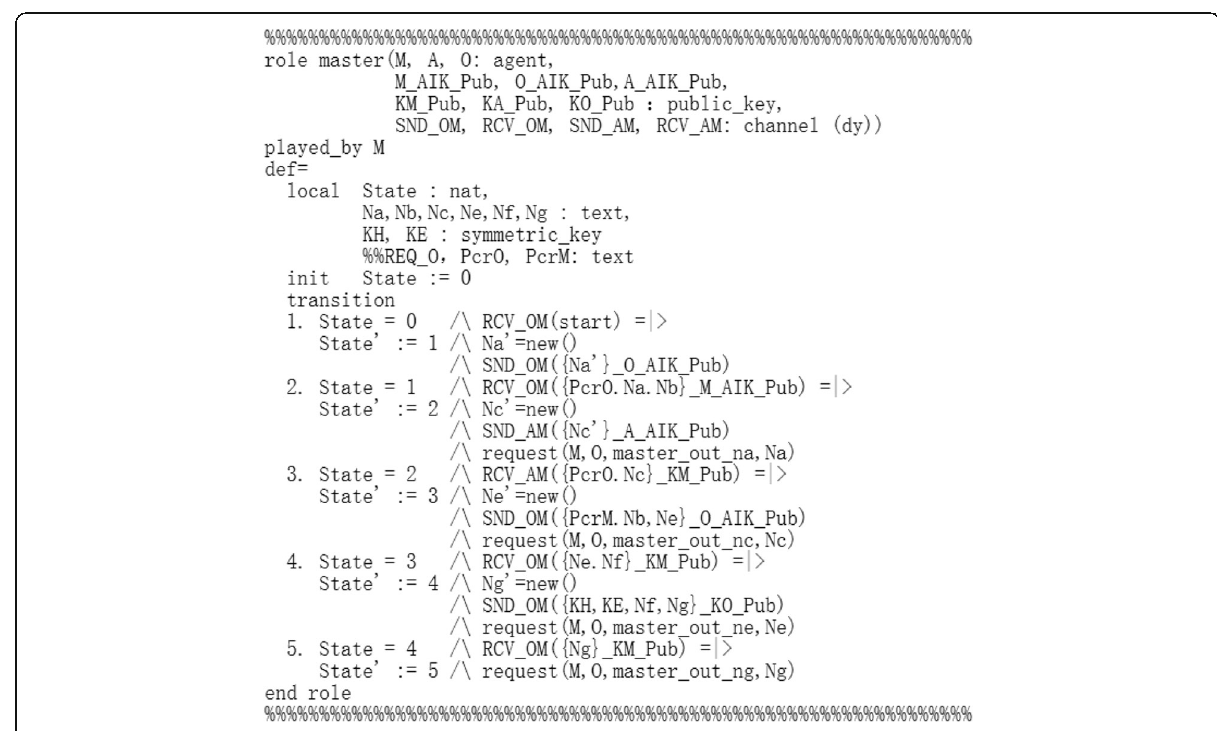
Fig. 7 The communication process of entity